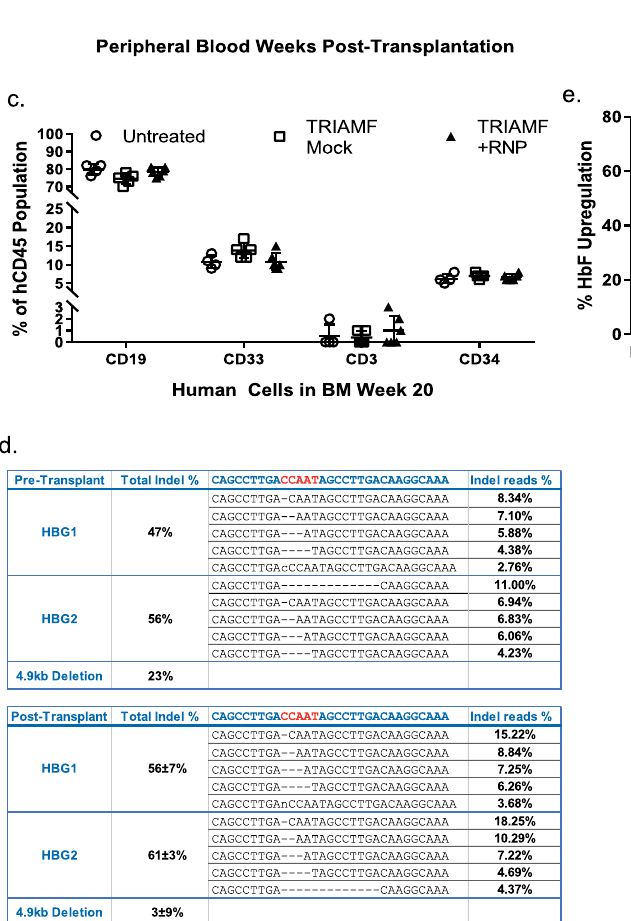
Compared with TRIAMF, electroporation of the same RNP complex targeting B2M into HSPCs at a much smaller scale using the Neon electroporator led to higher editing efficiency but the cell recovery rate was sig- nificantly compromised (Fig. S6). This difference seems not due to increased B2M knockout efficiency because cells treated with mock electroporation also had a slower recovery rate than the cells treated with mock TRIAMF